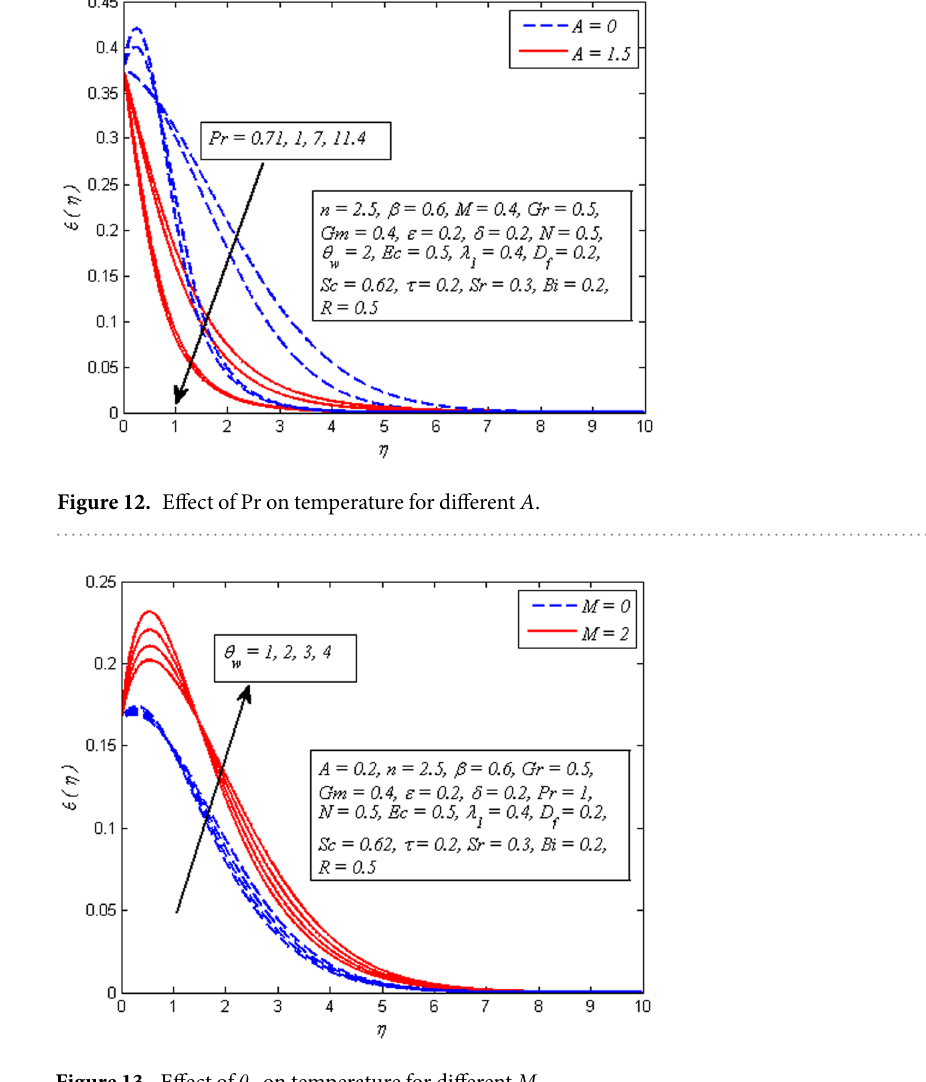
on temperature for different M . w